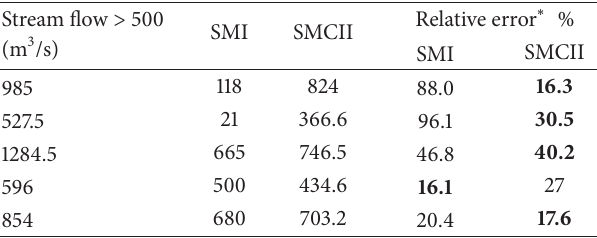
Table 5: Comparison of maximum flow predicted by SMI and SMCII methods during model